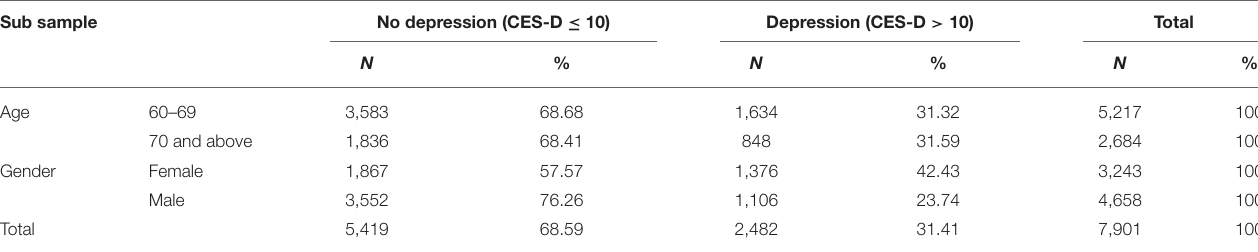
TABLE 1 | Depression in the